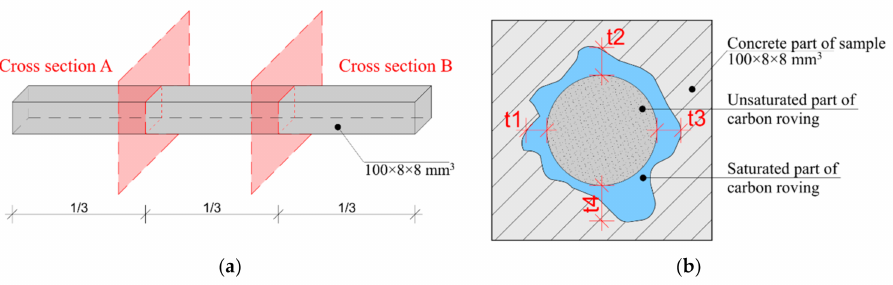
Figure 8. Experimental beam samples: ( a ) Scheme of experimental samples with cross-section position; ( b ) Method of the saturation depth